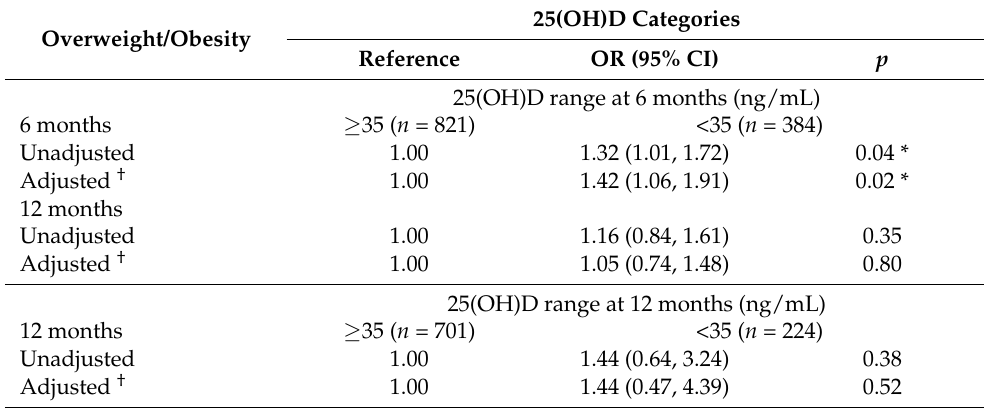
Table 5. Effects of 25(OH)D level on overweight/obesity in infants at 6 and 12